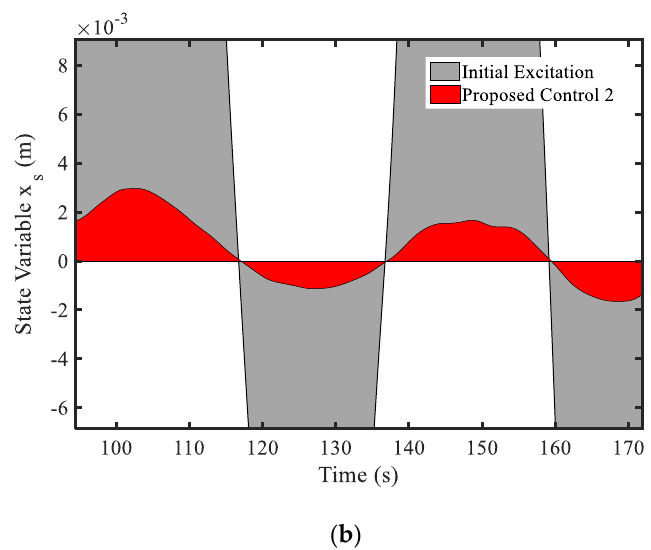
Figure 10. State variable (displacement) at the seat position: ( a ) general view, ( b ) large view.